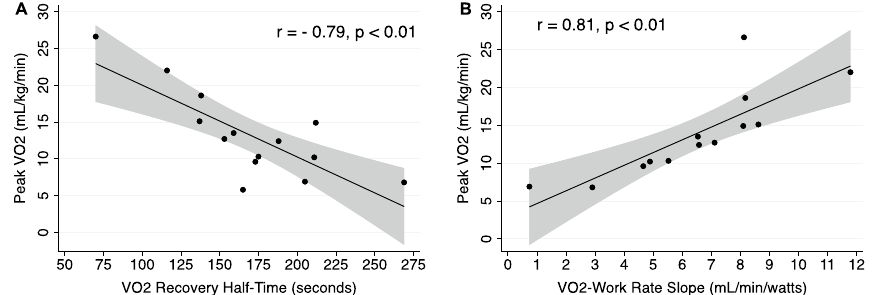
Fig. 2 Correlation plots of oxygen utilization measures and peak oxygen consumption during cardiopulmonary exercise testing. Measures of oxygen utilization during exercise and in recovery in cardiopulmonary exercise testing (CPET) are strongly associated with peak oxygen consumption. A Demonstrates the correlation between peak oxygen consumption (VO 2Peak ) and VO 2 -work rate slope. VO 2 -work rate slope quantifies the change in oxygen consumption as work increases during cycle ergometry. Lower values indicate less efficient oxygen consumption and poorer aerobic metabolism (i.e., mitochondrial dysfunction). B The relationship between VO 2Peak and VO 2 recovery half-time . VO 2 recovery half-time quantifies oxygen consumption during recovery after exercise as skeletal muscle creatine is re-phosphorylated by mitochondria via aerobic metabolism. Longer durations of VO 2 recovery half-time indicate impaired oxygen utilization and slower re-phosphorylation (i.e., mitochondrial dysfunction). All correlations calculated using Pearson’s correlation